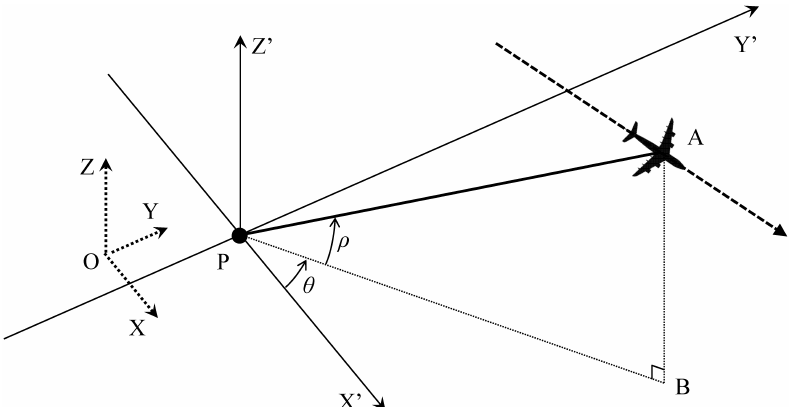
Figure 2. Geometry of one arbitrary station of